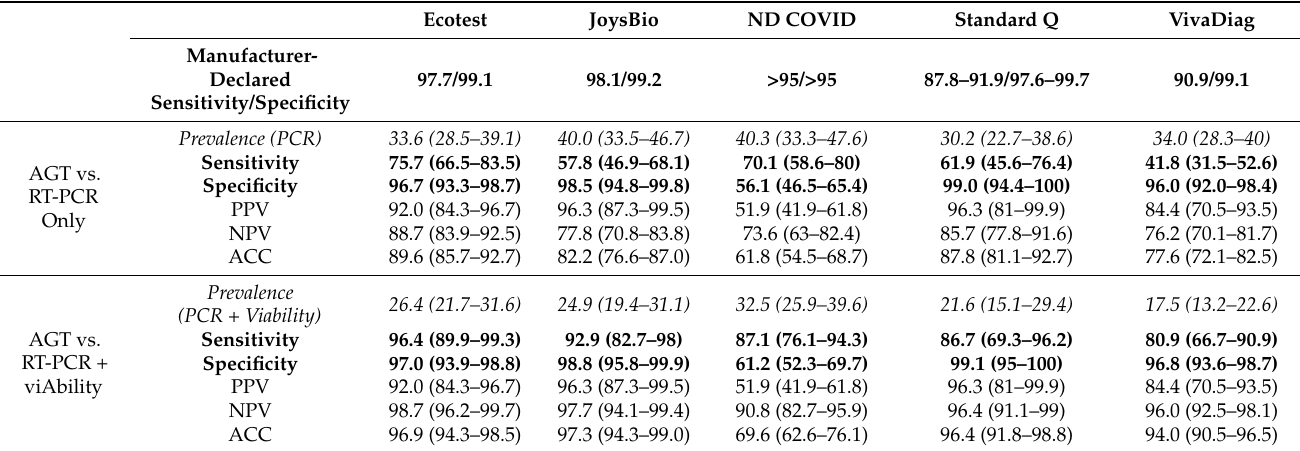
Table 3. Screening test performance metrics for individual tests when comparing antigen testing (AGT) results to RT-PCR and when comparing AGT results to RT-PCR corrected on the results of virus viability